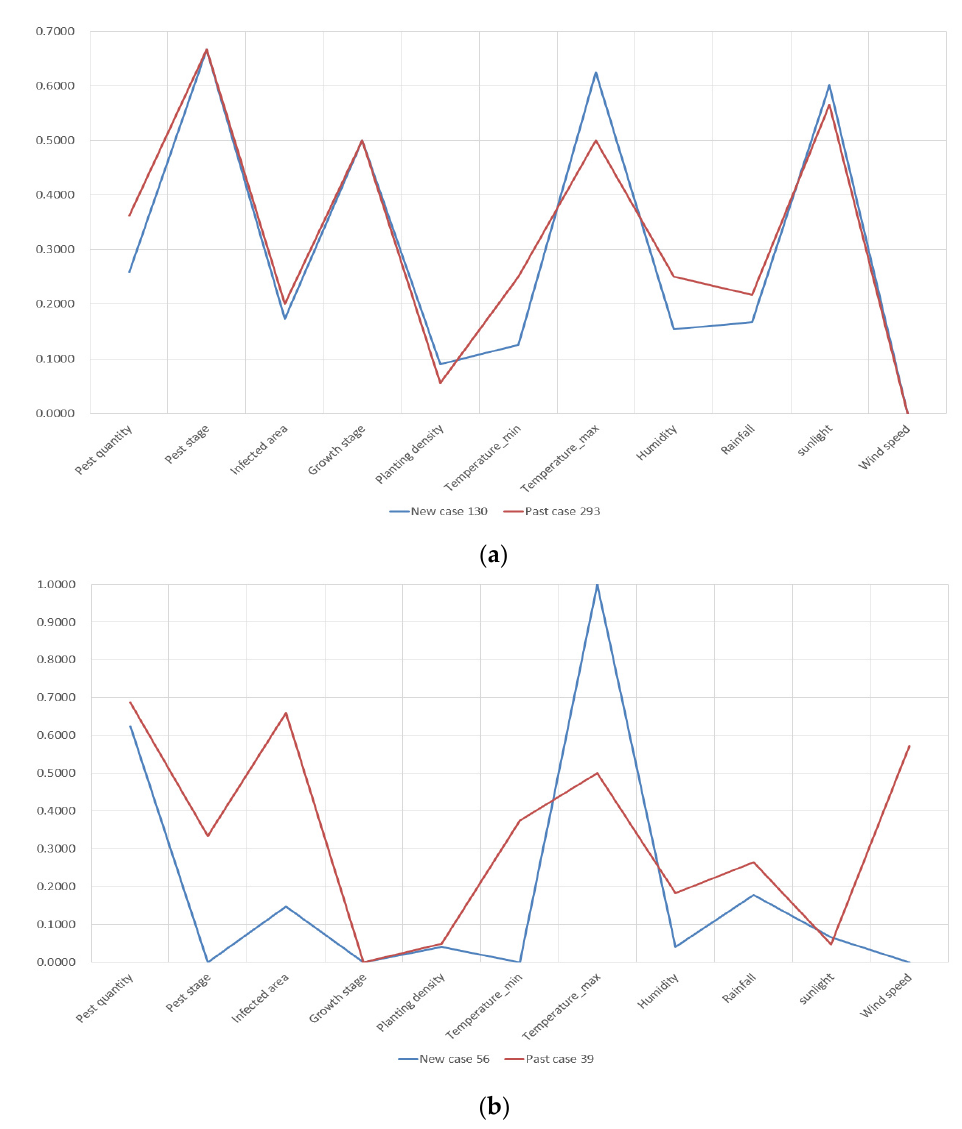
Figure 8. The similarity of retrieved cases: ( a ) the best situation; ( b ) the worst situation.